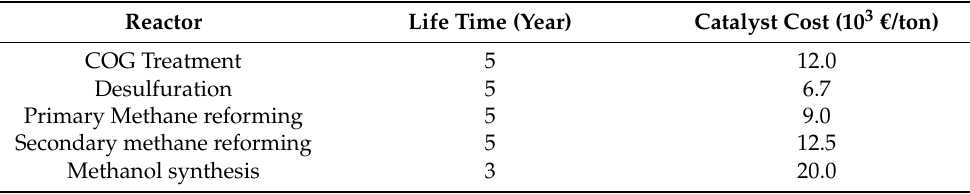
Table A2. Cost and life time of each used